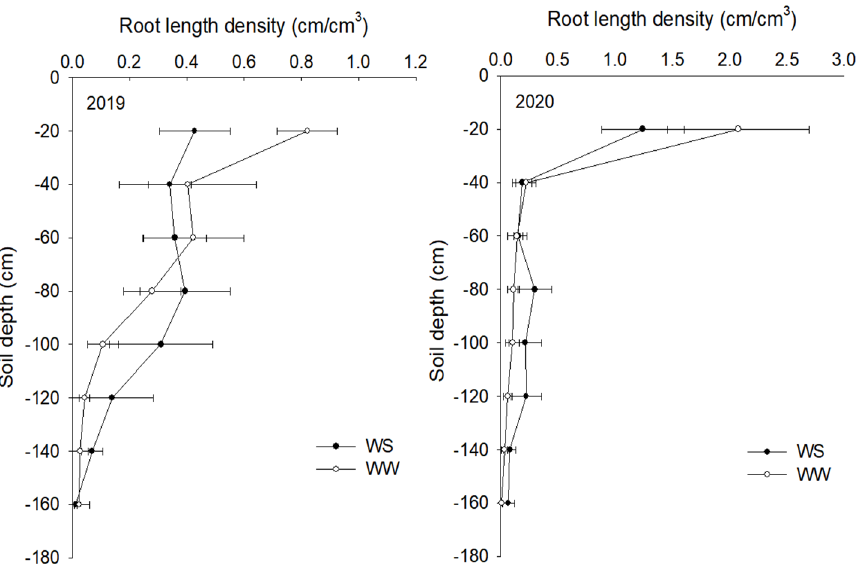
Figure 3. The distribution of the total root length (TRL) along the soil profile in 2019 for four varieties and 2020 for six varieties under well-watered (WW) and water-stressed (WS) treatments. (Bars represent the range of the RLD among the cultivars sampled.)